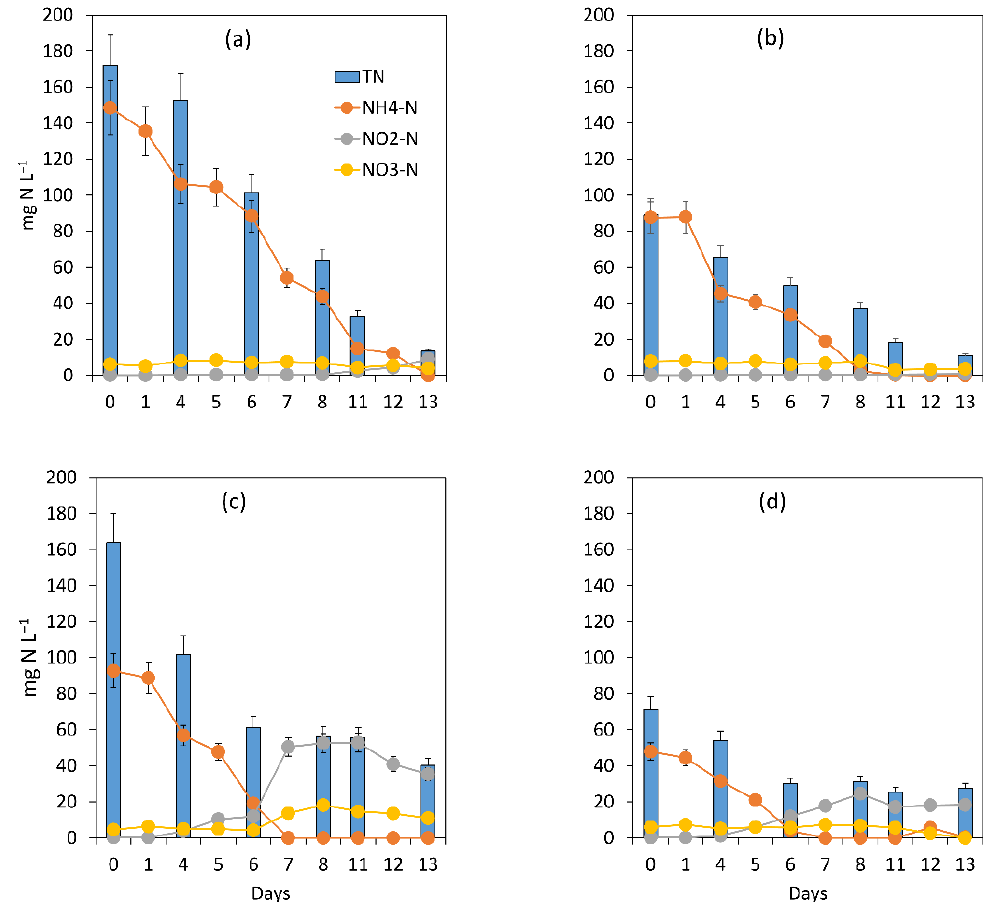
Figure 2. Concentration of different nitrogen forms in the reactors under the impacts of light and nutrient load. ( a ) HL.X5, ( b ) HL.X10, ( c ) LL.X5 and ( d ) LL.X10.